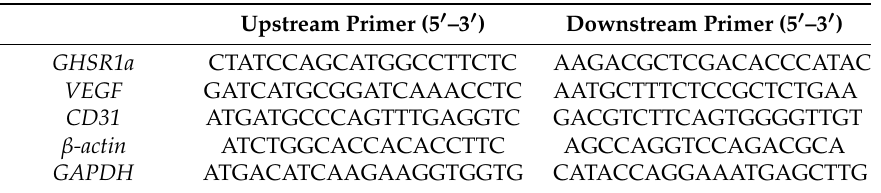
Table 1. List and sequence of